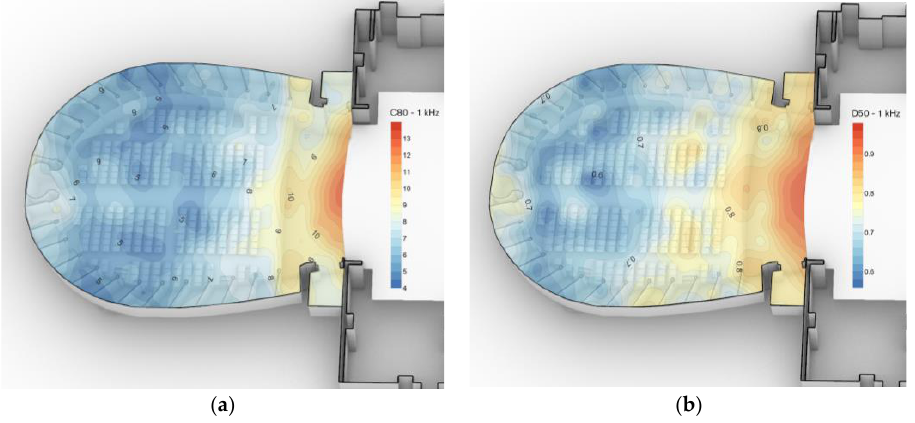
Figure 10. Spatial distribution of clarity index ( a ) and definition ( b ) at 1 kHz related to the Ponchielli theater of Cremona.